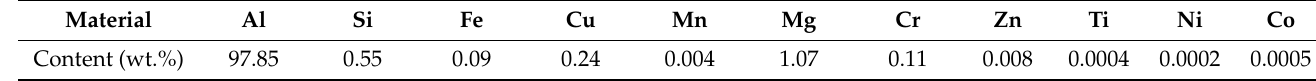
Table 3. Chemical composition of 6061Al alloy (mass